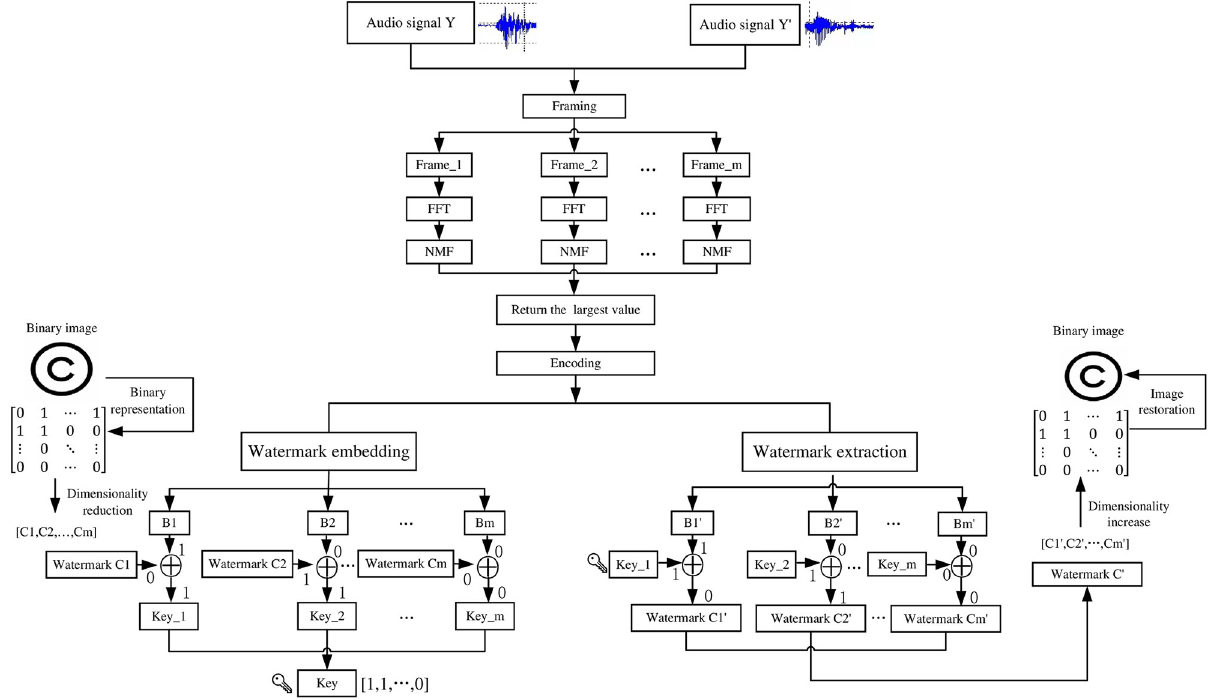
Fig 1. Watermark embedding and extraction